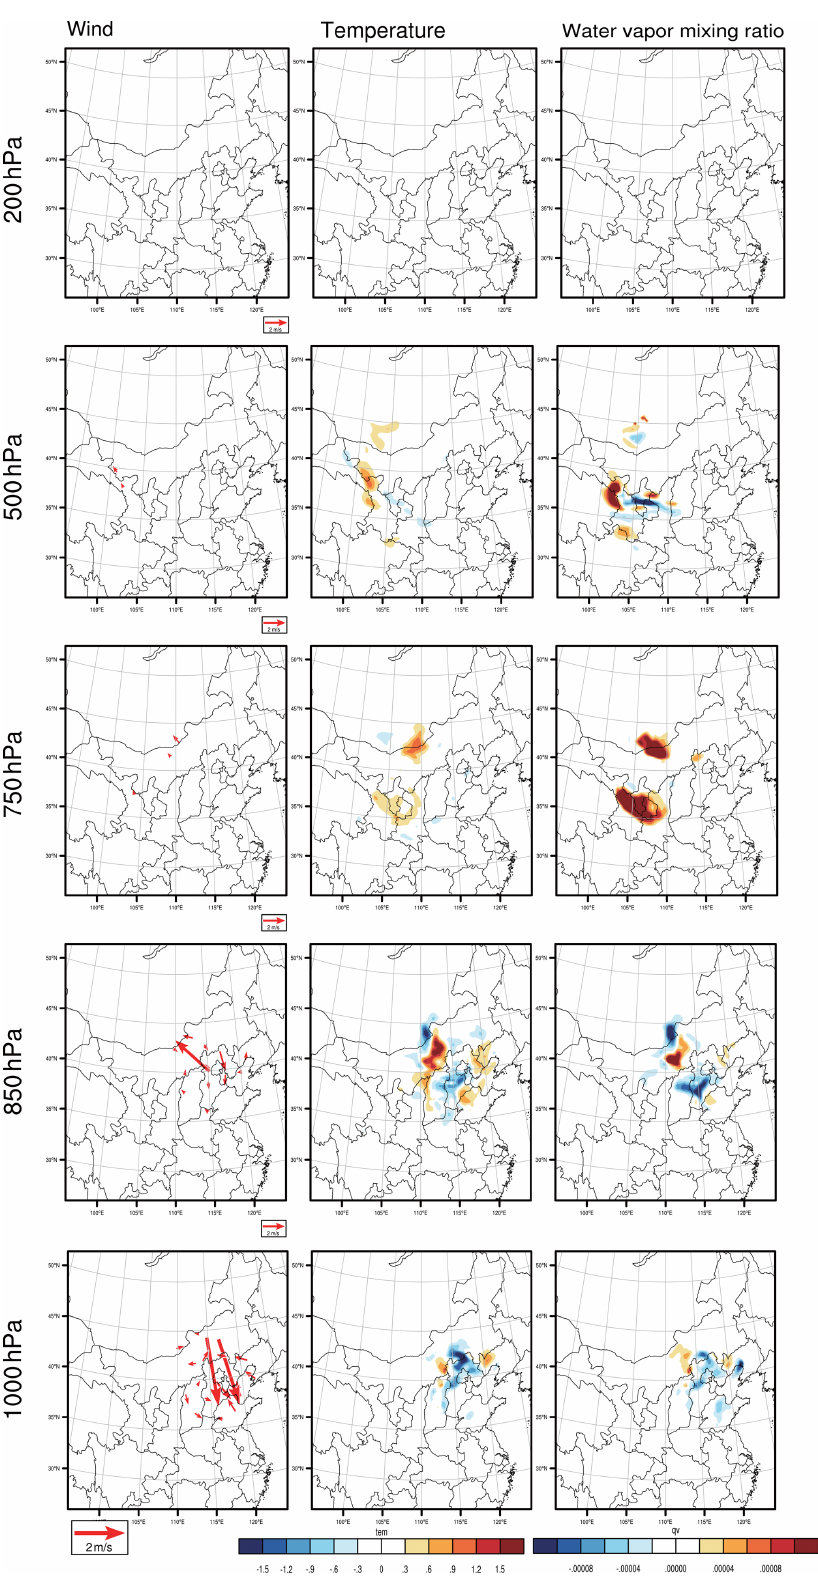
Figure 6. The same as in Fig. 3 but for the forecast starting from 02:00BJT on 3 December, with a lead time of 12h.